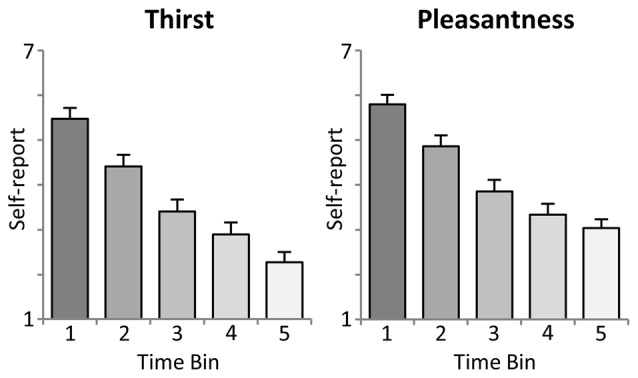
Illustration of the intra-task thirst ratings (mean ± SEM). Each time bin represents an interval of 10 trials, i.e., the ingestion of 100 ml of water.